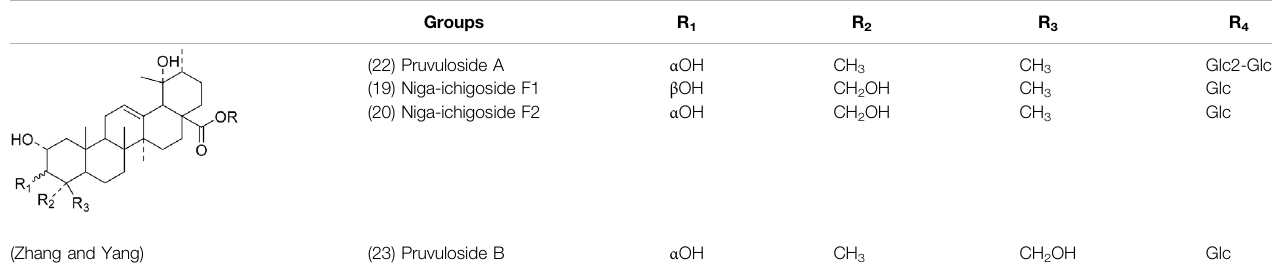
TABLE 2 | Chemical structures of triterpenes isolated from PVL ─ Part II.